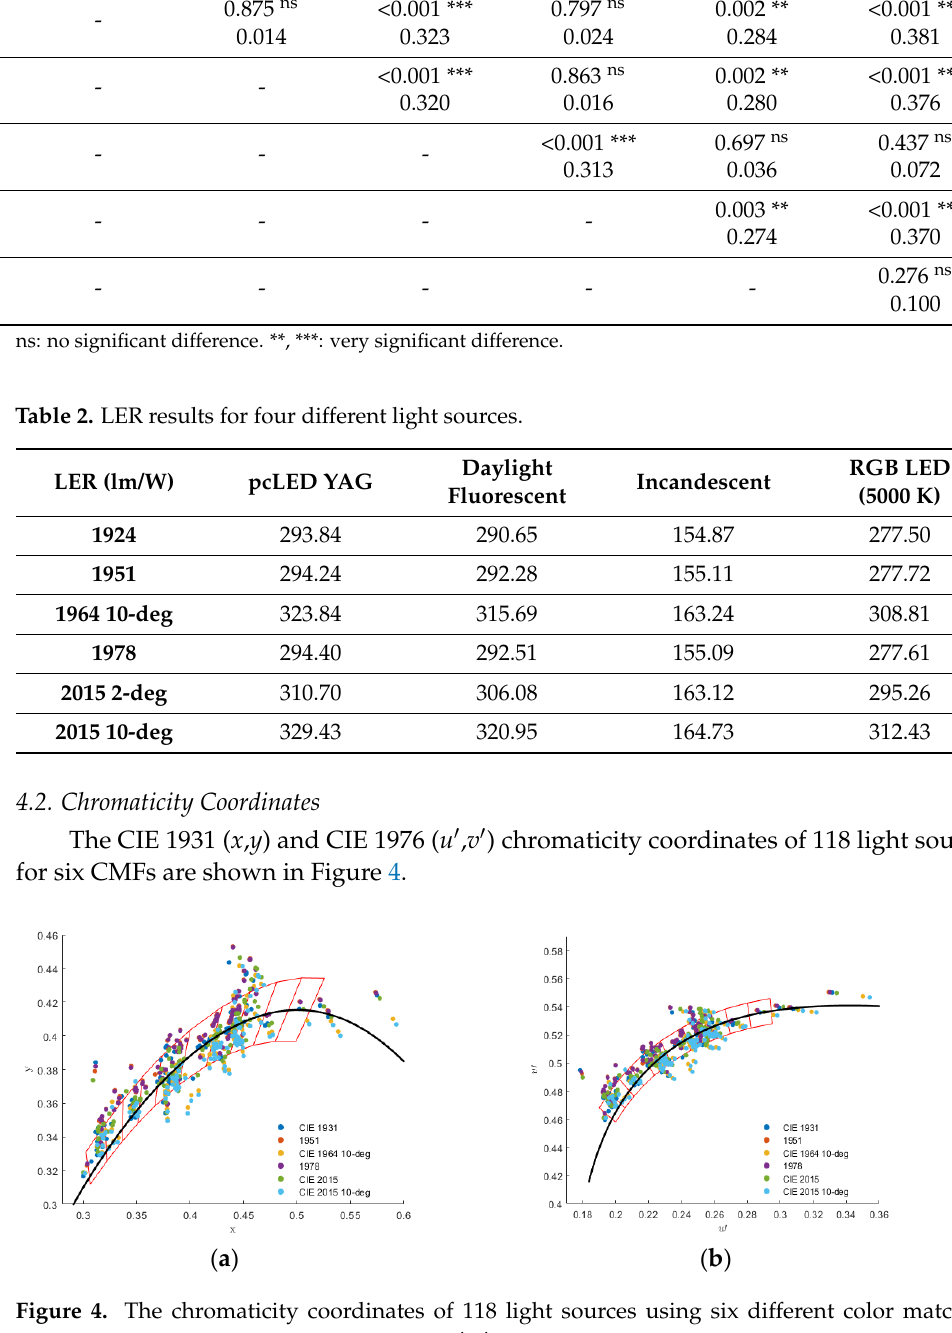
Table 3. Rank sum test and effect size for CIE 1931 x ( p -value and effect size ( r )) .